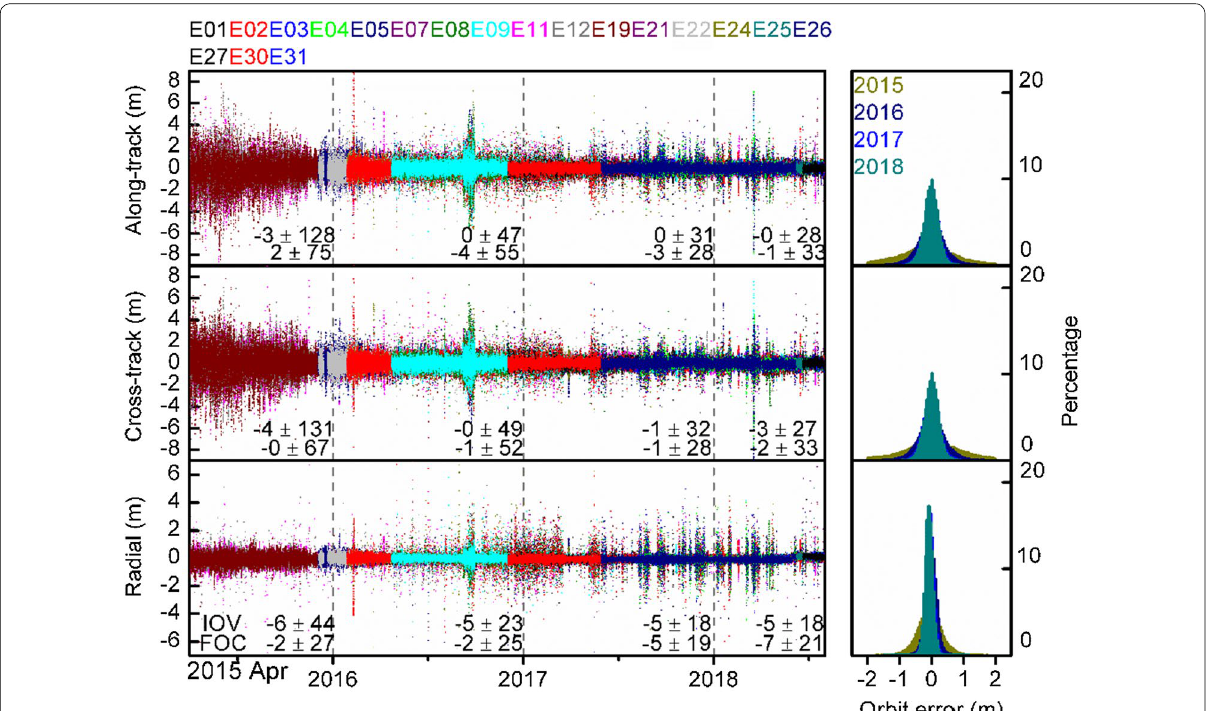
Fig. 3 Time series of Galileo FNAV broadcast orbit errors ( left ) and the frequency histogram ( right ). Mean and STDs of IOV and FOC satellites for each year are indicated at the bottom in